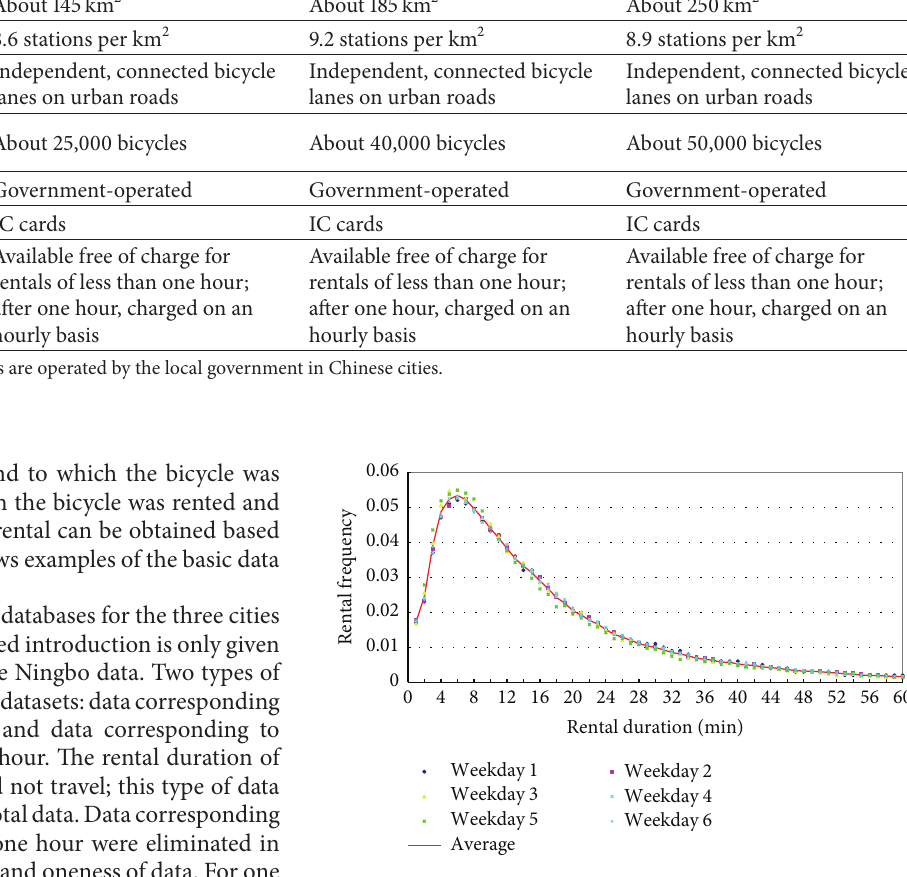
Figure 1: Frequency distributions of public bicycle rental duration in